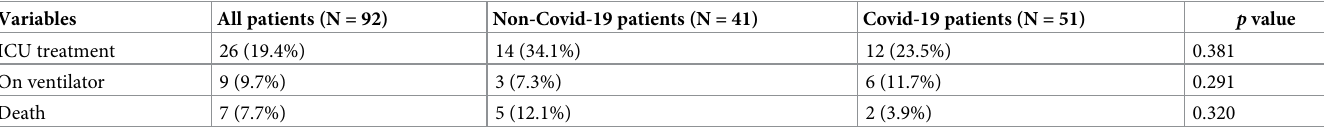
Table 4. Outcome comparison of COVID-19 and non-COVID-19 patients.